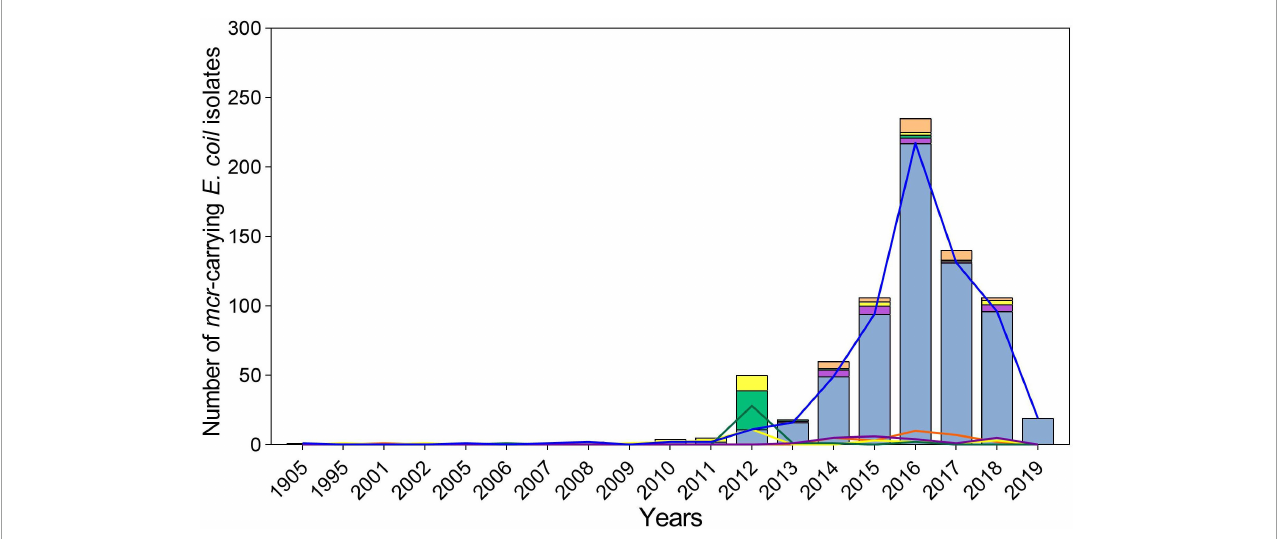
FIGURE1 Characteristics of global spread of mcr-positive Escherichia coli per year. The light blue columns and blue lines represent mcr-1, the mauve columns and purple lines represent mcr-3, the light green columns and green lines represent mcr-5, the yellow columns and lines represent mcr-9, and the orange columns and lines represent the combination of varied mcr genes.